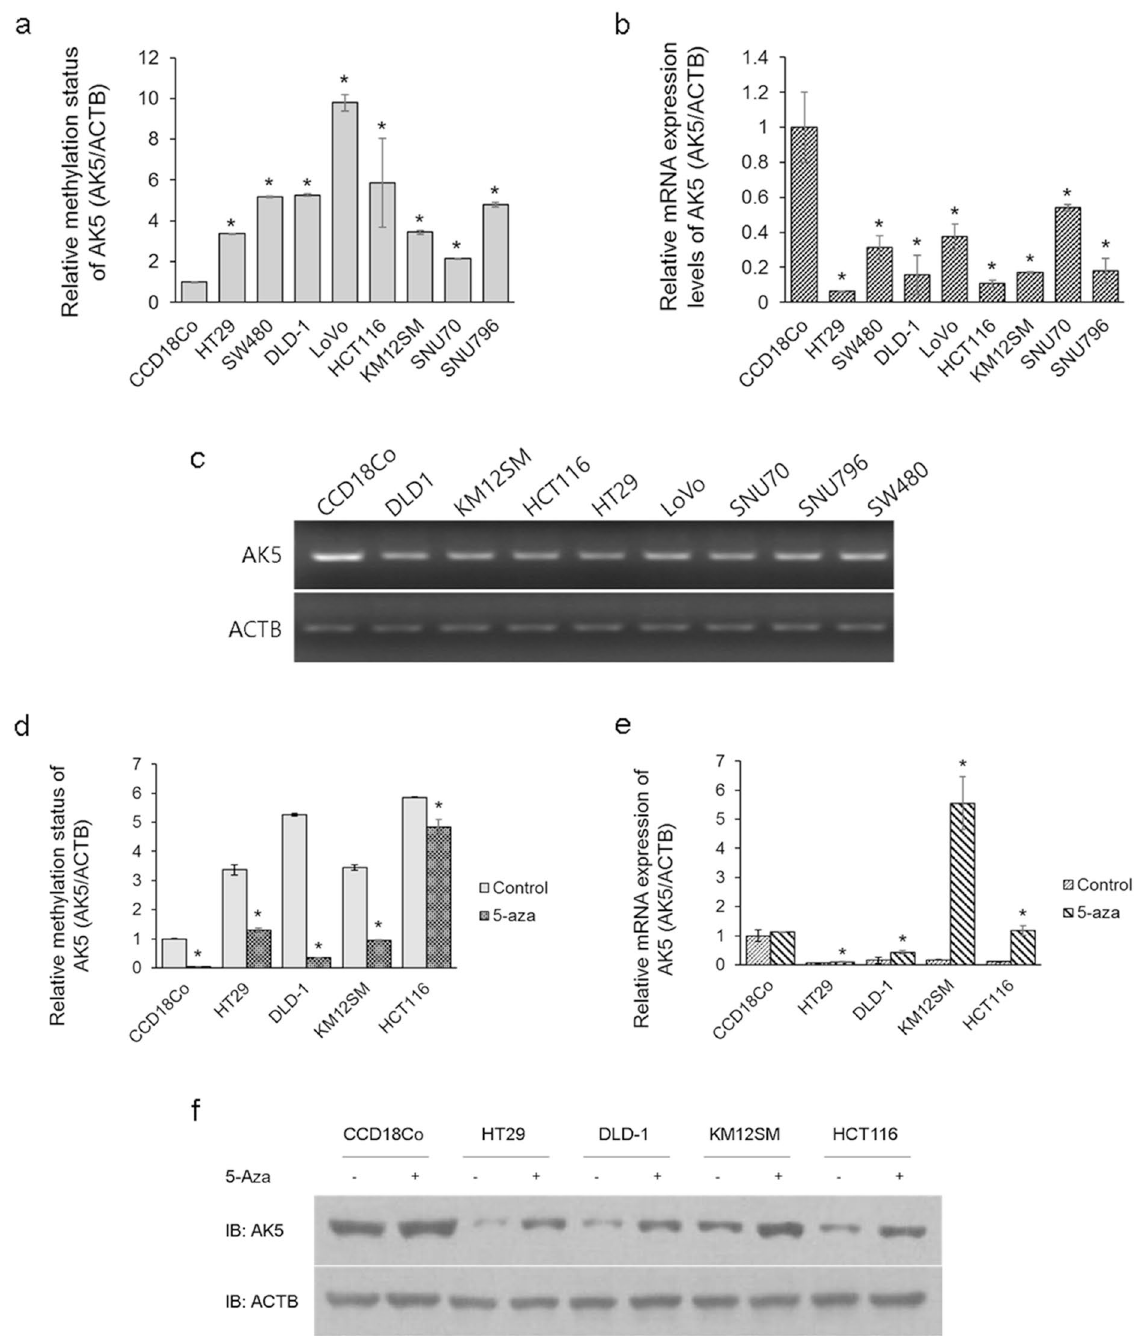
Figure 2. AK5 methylation and expression changes after treatment with 5-aza in CRC cell lines and a normal colon fibroblast cell line. Methylation status, and AK5 expression levels were observed using qMSP, real-time PCR, and immunoblot analysis. ( a ) AK5 was significantly hypermethylated in eight CRC cells compared with normal colon cells. ( b , c ) AK5 mRNA expression decreased in eight CRC cells compared to the normal colon cells. ( d ) AK5 DNA methylation decreased in four CRC cells and the normal colon cells after 5-aza treatment. ( e ) AK5 mRNA expression increased in four CRC cells after 5-aza treatment. ( f ) AK5 protein expression increased in four CRC cell lines due to 5-aza. GAPDH or ACTB were used the loading controls. Original gel images of AK5 protein expression are presented in Figure S5b. *P-values of < 0.05 were considered statistically significant. IB,